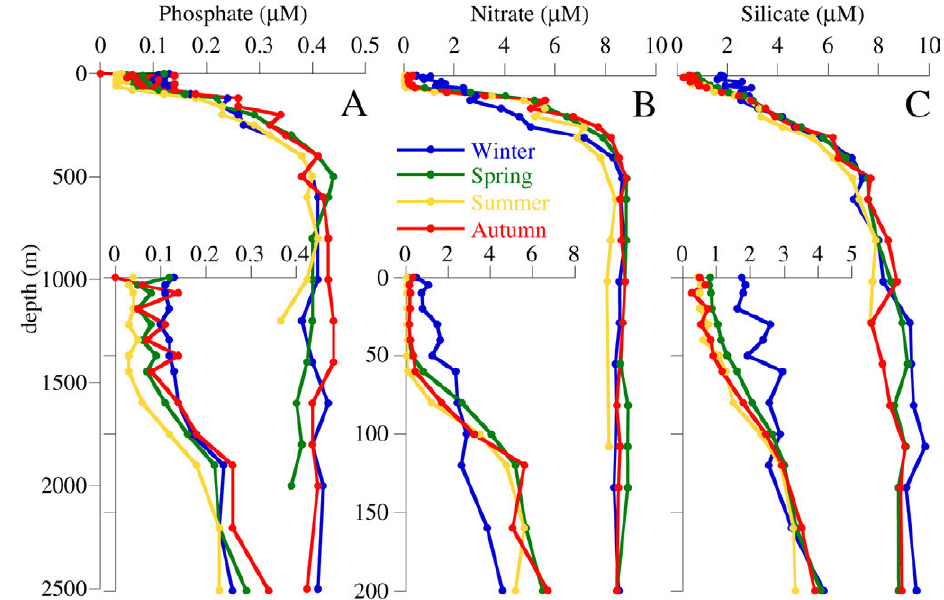
Fig. 3. – Seasonal depth concentration profiles of phosphate (A), nitrate (B) and silicate (C) in open sea stations (bottom depth>200 m) of the Catalan Sea. The first 200 m are enlarged in the small